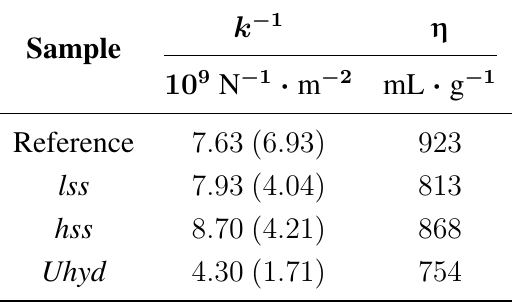
Table 4. The experimental average compliances ( k − 1 ) for untreated Kraft pulp fibers (Reference) according to Saketi et al. [30], and, for pulp samples from this work are presented with cellulose fraction corrected limiting viscosity numbers ( η ). Standard deviation for the compliances are indicated in the parentheses.